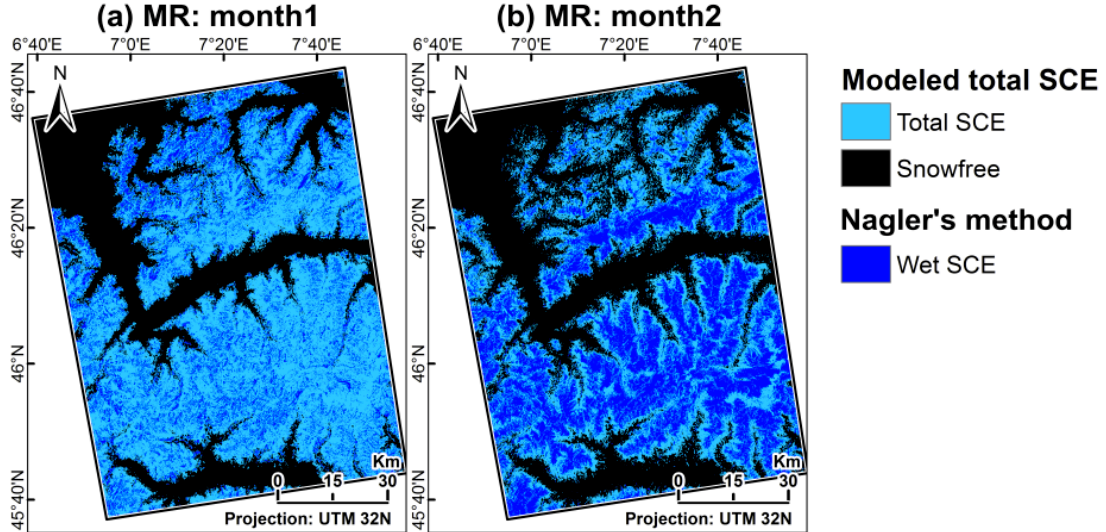
Figure 11. Total and wet SCE of Monte Rosa (MR) region ( a ) month1: 2018 March 12 ( b ) month2: 2018 May 11. Figures are revised from Tsai et al. [143]. Note the total SCE is modeled based on backscatter, InSAR coherence, and PolSAR parameters; wet SCE is estimated based on conventional backscatter-threshold approach.